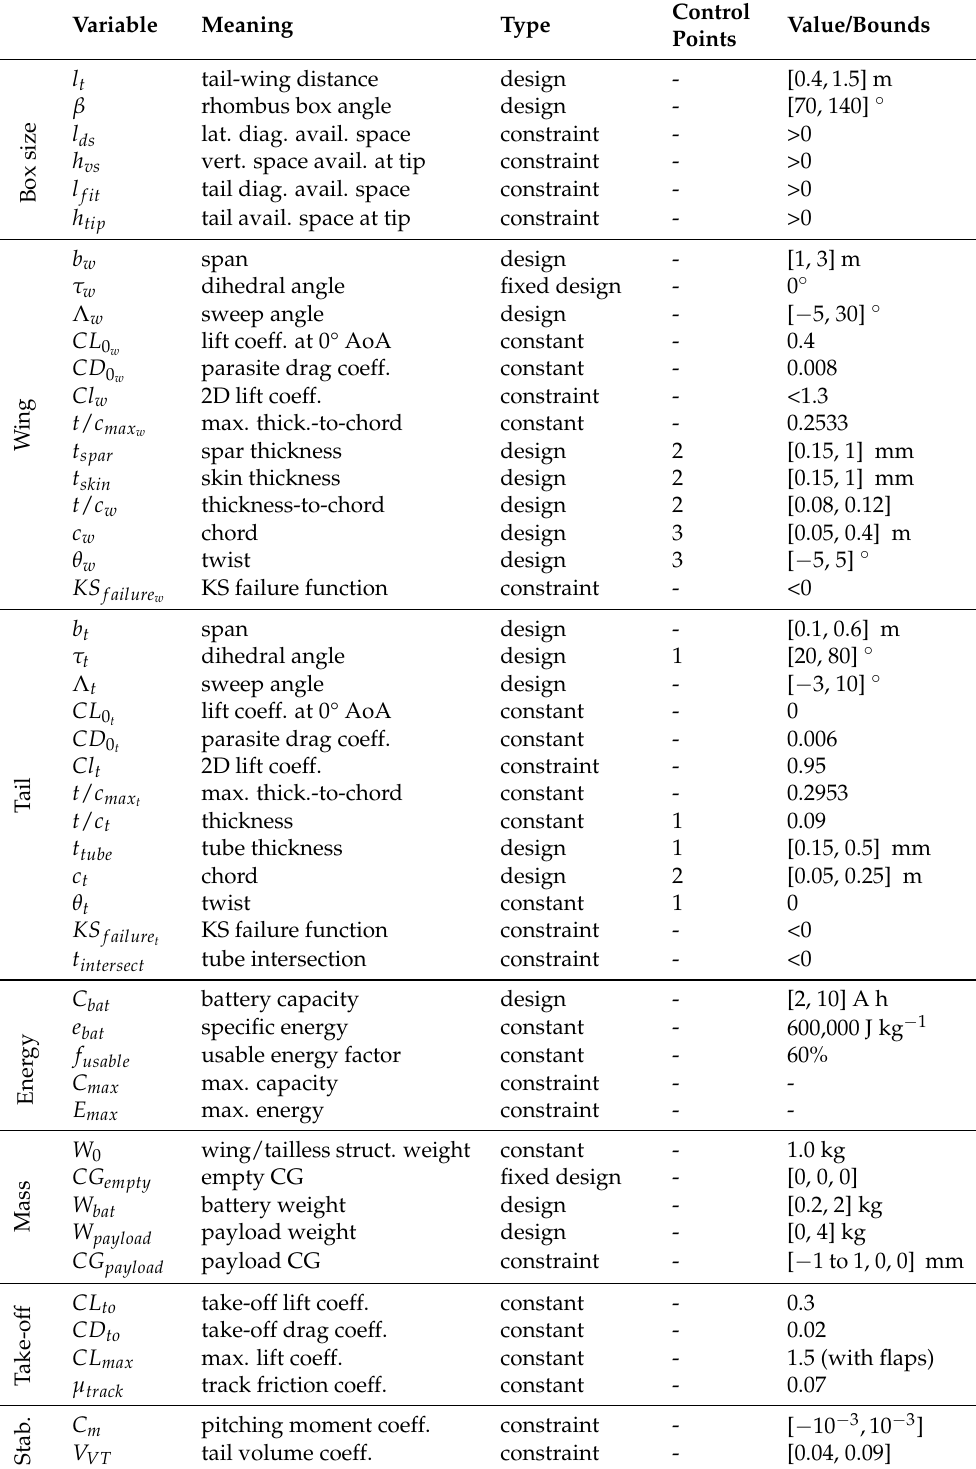
Table 2. Aircraft design